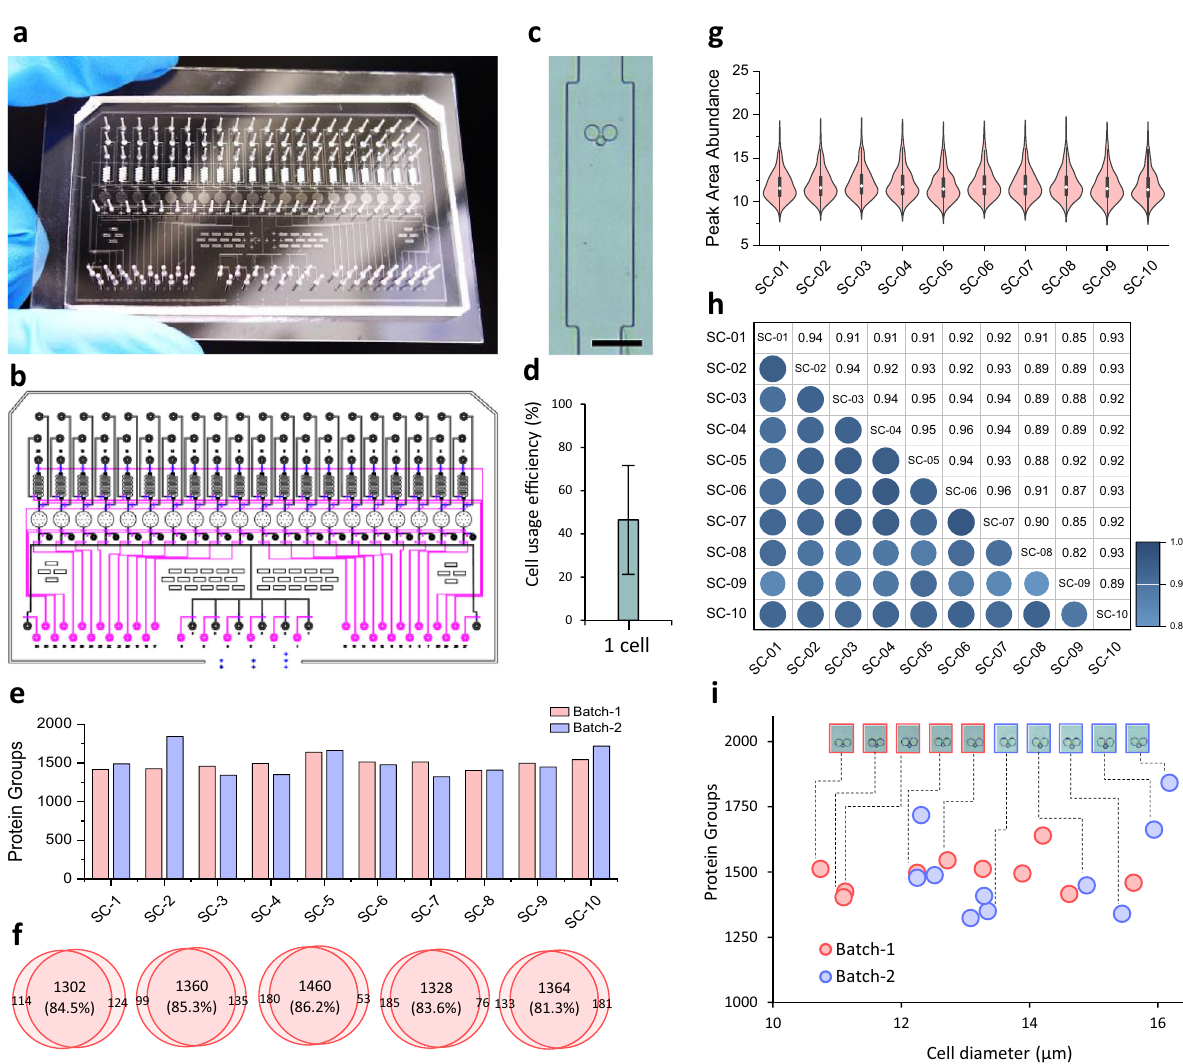
Fig. 6 Single-cell integrated proteomics chip (SciProChip) for 20-plex single-cell proteomic analysis. a A photograph of SciProChip for parallel processing of 20 single cells. b A schematic of the overall SciProChip layout. The control layer is shown in pink, while the fl ow layer is shown in black and blue. Note that SciProChip contains 20 operational units. c A bright- fi eld image of a capturing chamber with a trapped cell. Scale bar: 120 μ m. d The cell usage ef fi ciency of SciProChip. Data are presented as mean values ± SD ( n = 28 independent measurements). e Protein group identi fi cation of 10 single cells from 2 independent experimental batches. SC: single cell. f Overlaps of protein groups identi fi ed in replicate analyses and g distributions of total protein abundances in identi fi ed proteins of single cells shown in e . Each data was analyzed as an individual measurement. Centerlines show the mean; box limits indicate the 25th and 75th percentiles; whiskers, 1.5× interquartile range. h Pairwise Pearson ’ s correlation showing the reproducibility of protein abundances obtained across different single cells. i Correlation between the estimated cell sizes and protein groups identi fi ed of 20 single cells. Source data are provided as a Source data fi